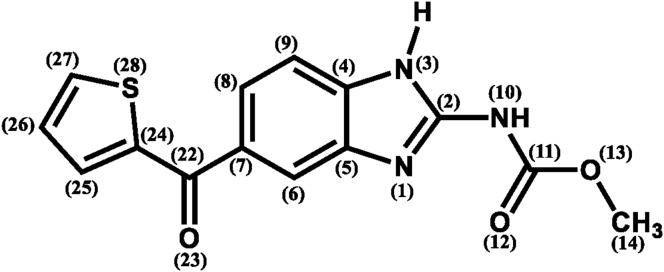
The 2D structure of Nocodazole displaying atoms number in consistency with data in Table 2.